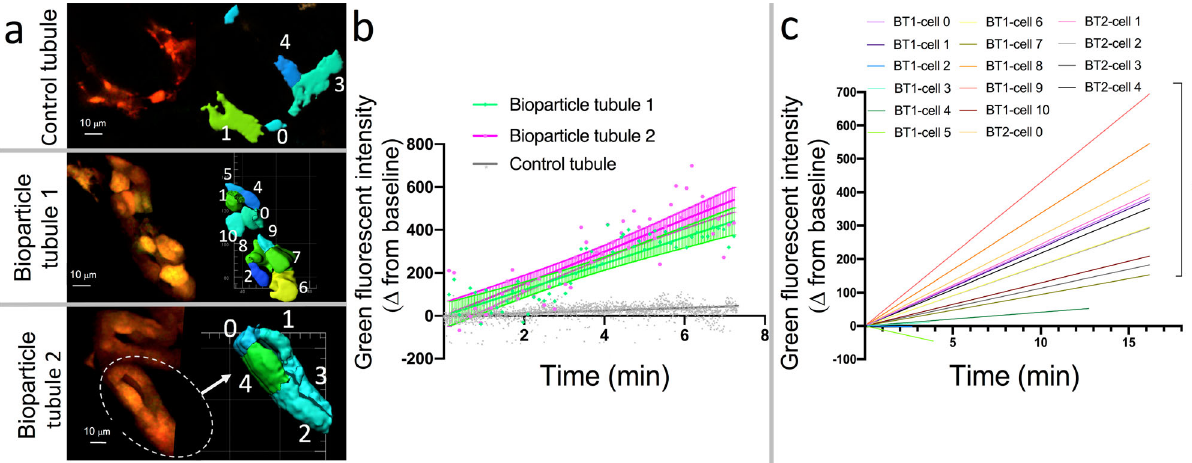
Fig. 9 Imaris quanti fi cation of green fl uorescence following tubular microperfusion with pHrodo Green E. coli BioParticles demonstrates increased uptake and acidi fi cation by ICs over time. a Tubules of “ IC reporter ” mice with red ICs along with Imaris segmentation pro fi les are presented for control (top panel) and pHrodo Green E. coli BioParticle perfused tubules (middle and bottom panels). Segmentation cartoons (right panels) are not to scale. ( b ) Because pHrodo Green BioParticles fl uoresce green when internalized and acidi fi ed in phagolysosomes, we compared the mean change in green fl uorescent intensity for the IC component of each tubule over time. The change in green fl uorescence from baseline over time increased signi fi cantly for both coated E. coli -exposed bioparticle tubule 1 (BT1) and bioparticle tubule 2 (BT2) compared to the control tubule (CT). Linear regression was used to compare tubules and cells, and the results are presented as the mean ± 95% con fi dence interval. For BT1, BT2, and CT, respectively, the R 2 was 0.28, 0.12, and 0.04, the slope was 60.9, 74.8, and 6.8, the DFn was 1467, 1264, and 17264, the F was 66.5, 104.6, and 217.5, and the Sy.x was 329.8, 244.8, and 56.5. The slopes of BT1 and BT2 were both signi fi cantly higher than the slope of CT ( P < 10E − 15), but not different from each other ( P = 0.221). c Within the bioparticle-perfused tubules, 12 of 16 tdT + ICs had a slope that increased signi fi cantly compared to a zero-slope line. Thus, there is some heterogeneity in IC phagocytic capabilities. During linear regression, Graphpad Prism compares slopes by calculating a two-tailed p value to test the null hypothesis that the slopes are identical. For the tubule analysis ( b ), slopes were compared to one other tubule (BT1 vs. BT2, BT1 vs. CT, and BT2 vs. CT). For the cell analysis ( c ), the slope of each cell was compared individually to a zero-slope line. Multiple comparisons were not used. Analysis included 2 bioparticle tubules (one with 11 ICs and the other with 5 ICs) and 1 control tubule (with 5 ICs) from one mouse each. Source data are provided as a Source Data Single-cell RNA sequencing (ScRNA-seq) . The single-cell 3 ′ RNA-seq experi- ment was conducted using the Chromium single-cell system (10× Genomics, Pleasanton, CA) and the NovaSeq 6000 sequencer (Illumina, CA). Each single-cell suspension was fi rst counted on the countess II FL (Thermo Fisher Scienti fi c) as well as under light microscope for cell number, cell viability, and cell size. Single- cell preparation included resuspension, centrifugation, and fi ltration to remove cell debris, dead cells, and cell aggregates. The resulting single-cell suspensions had viabilities of 75% and 83% with concentrations of 200 and 510 live cells per µl of sample for saline- and UPEC-exposed cells, respectively. Five- to ten- thousand cells per sample were added to a single-cell master mix, following the Chromium single-cell master mixture containing an aliquot of single-cell suspension was loaded to the Chromium controller for gel bead-in emulsions (GEM) generation and barcoding, followed by cDNA synthesis and library preparation. At each step, the quality of cDNA and library was examined by Bioanalyzer. The resulting libraries were sequenced using a custom program for generating 26 and 98-bp paired-end reads on an Illumina NovaSeq 6000 (Illumina NovaSeq 6000 control software version 1.6.0 and the Real time analysis version 3.4.4).